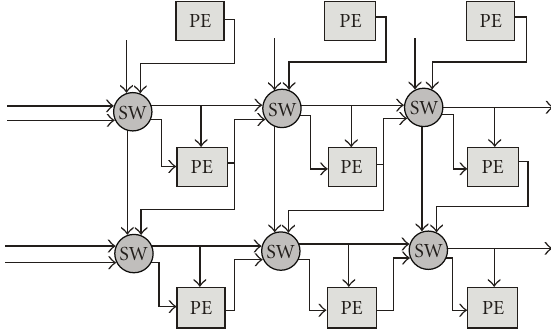
Figure 7: Block diagram of the RSA architecture.